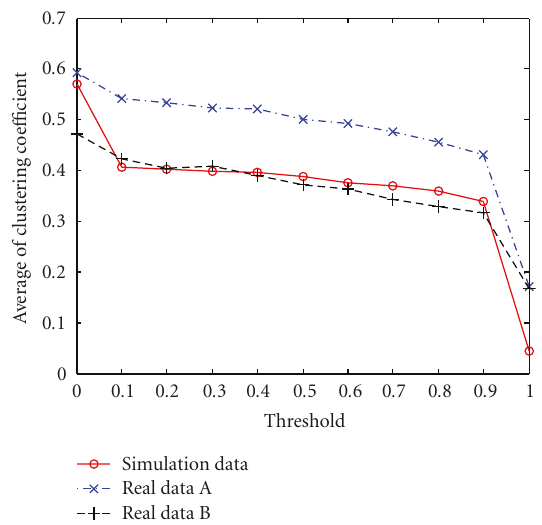
Figure 5: Variation of mean of clustering coe ffi cient with threshold. a sphere. Assume we have a collection of rectilinear triangles ab k c k , where k = 1,2, ... , n . In each such triangle, let α k = ∠ b k ac k be the angle at the vertex a . α k is easily computed using the rectilinear law of cosine, in which case it is called Alexandrov angle for background Euclidean